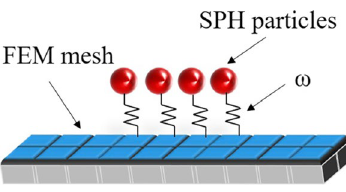
Fig. 5 SPH particles coupled with FEM elements